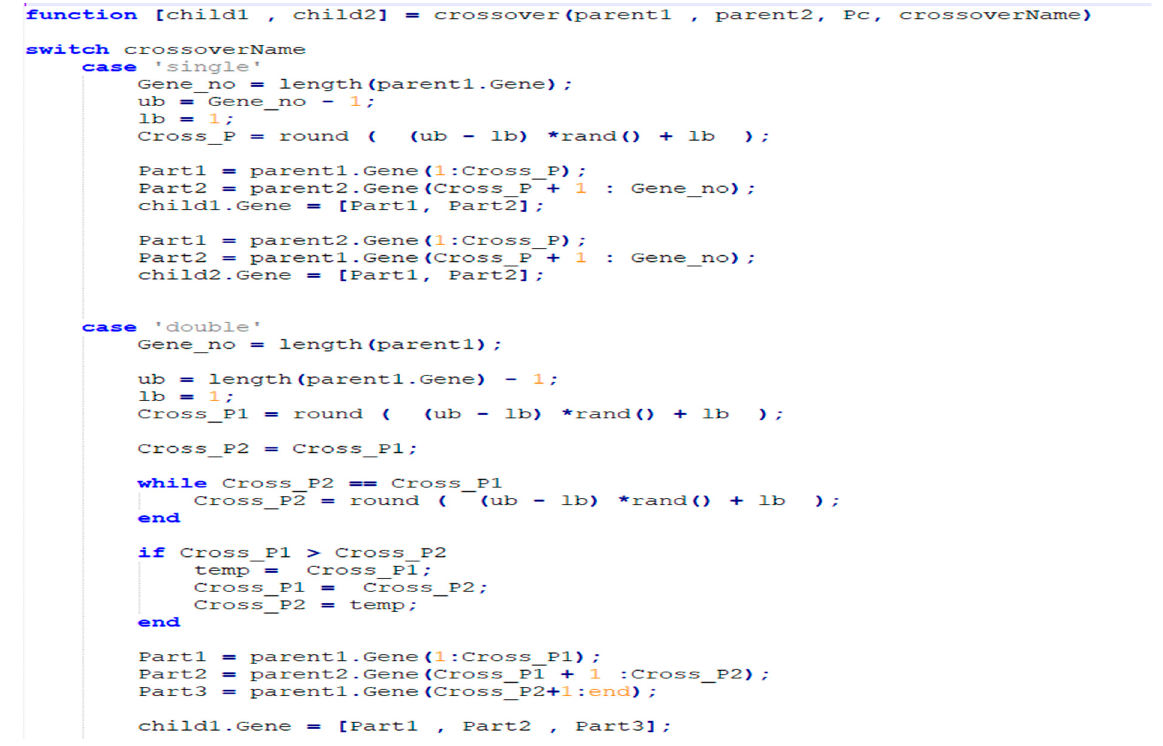
Figure 10. A genetic algorithm code sample. Table 10. Computer